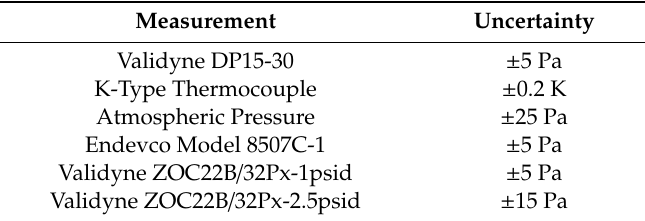
Table 1. Experimental uncertainty estimates of the measured rim seal chamber and turbine